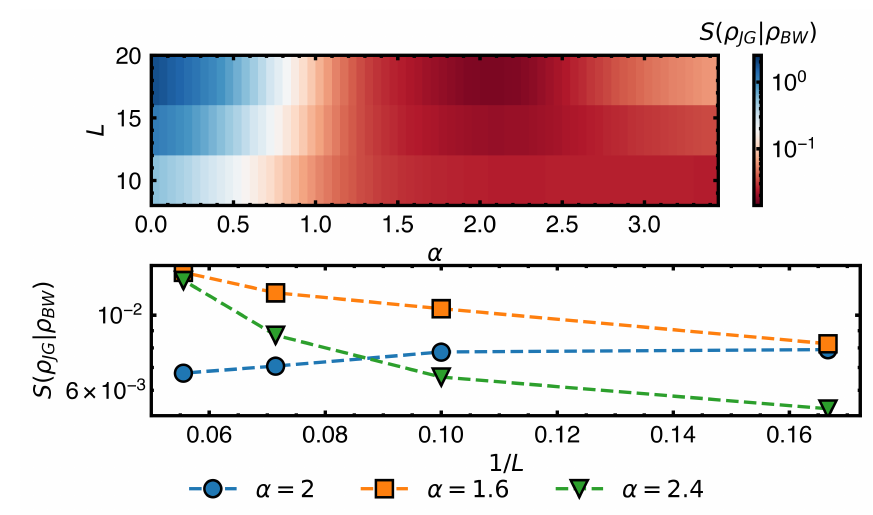
Figure 13: Relative entropy between converged BW density matrix and the JG one for the long range model Eq. (43) for L = 8,12,16,20. The results show a decreasing relative entropy for α = 2, which suggests the algorithm is approaching thermody- namic convergence. Instead, even points close to this Haldane-Shastry point exhibits increasing entropy, and certifying only an approximate